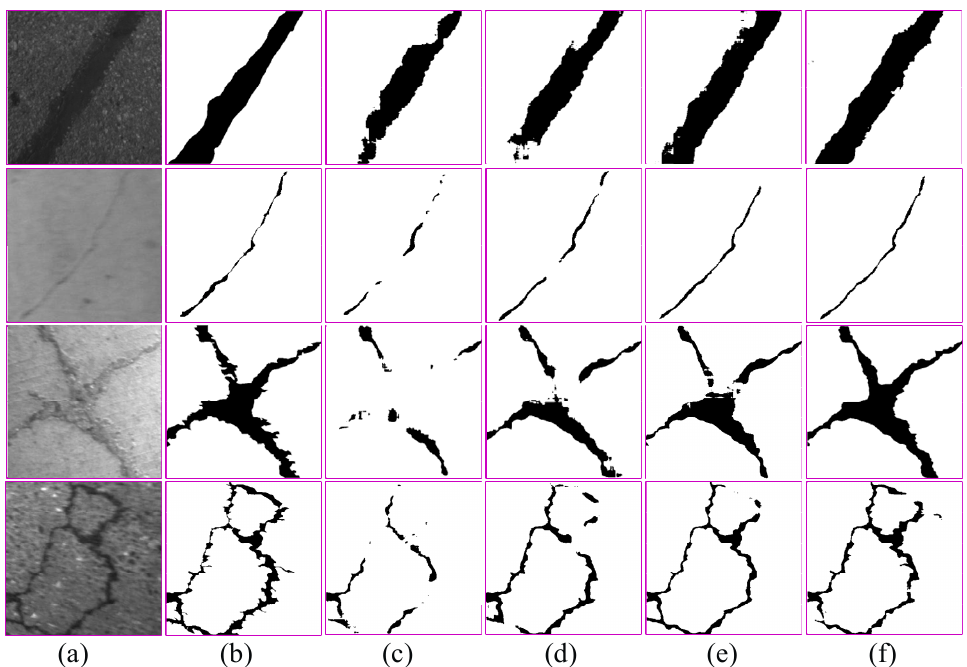
Figure 13. The segmentation performance with different data augmentation techniques. ( a ) The original image of road pavement distress. ( b ) The ground truth. ( c ) The segmentation results without data augmentation. ( d ) The segmentation results using only image enhancement. ( e ) The segmentation results using only geometric enhancement. ( f ) The segmentation results of using the two data augmentation techniques.